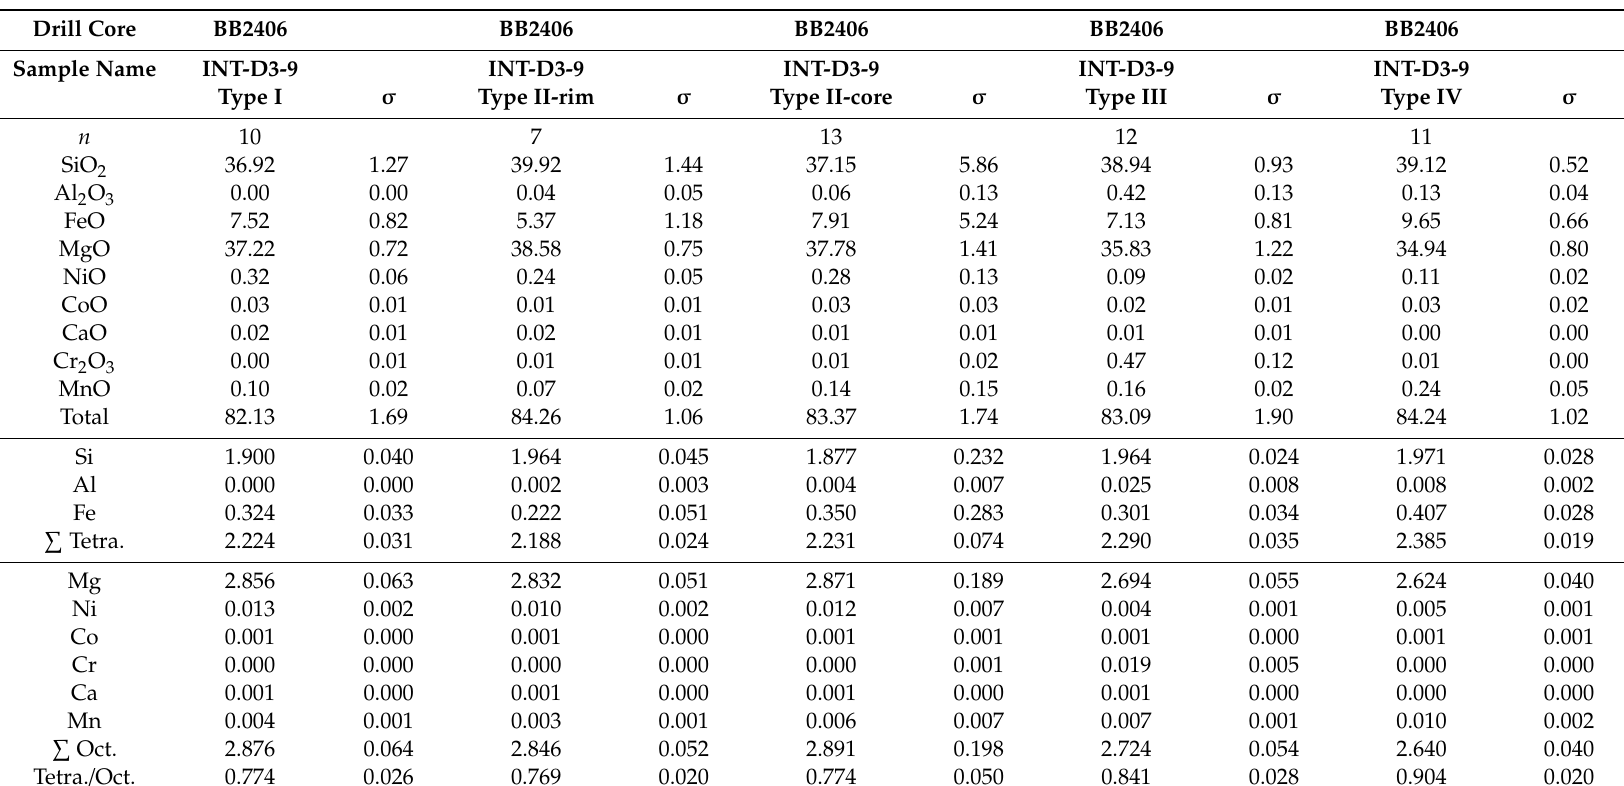
Table 4. Average chemical compositions and structural formula (apfu) of the di ff erent veins serpentines in the saprock derived from harzburgite-dunite